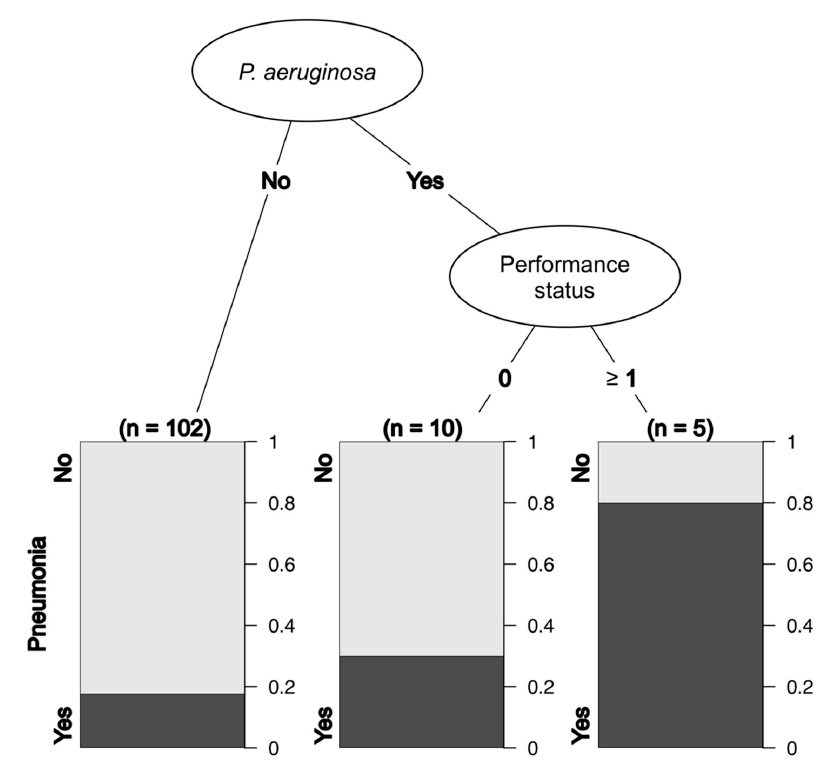
Figure 2. Kaplan–Meier plot and numbers-at-risk table for the probability of pneumonia-free survival. Control group: patients with normal oral flora and those who tested negative for bacteria. * p < 0.05.